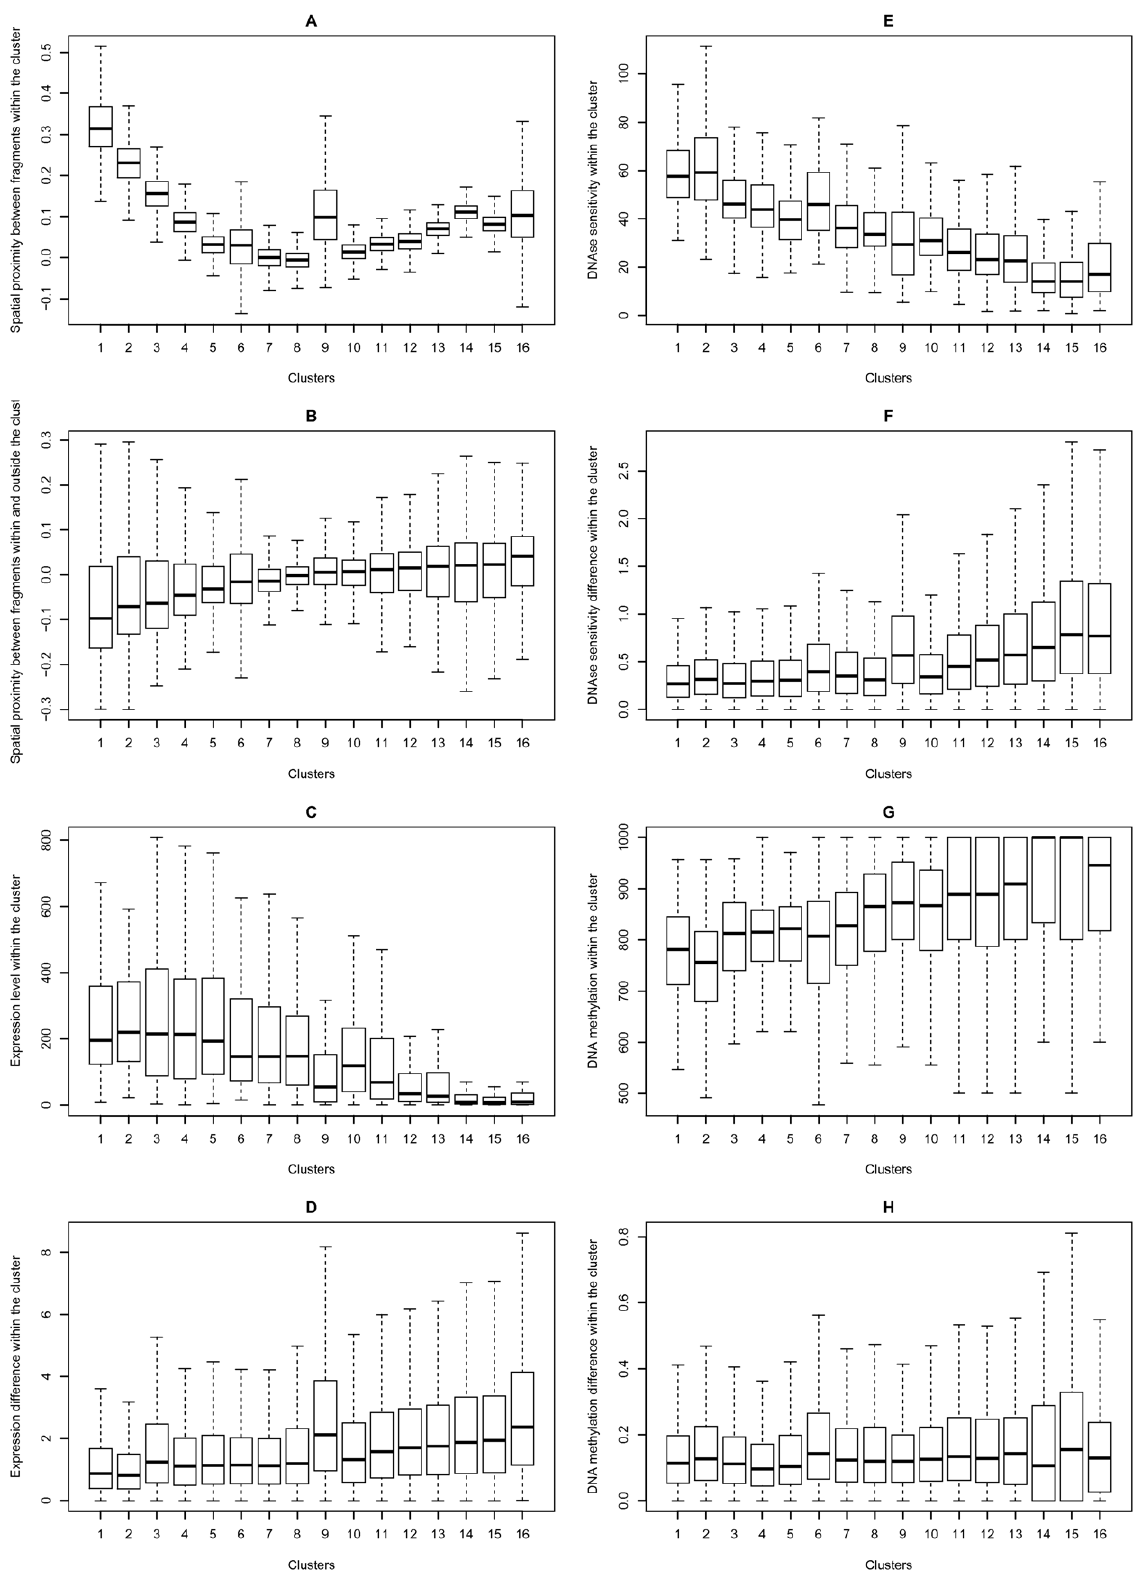
Figure 8. DNA fragments clustered into 16 groups. (A) spatial proximity between all possible pairs of DNA fragments within the cluster; (B) spatial proximity between each DNA fragment within the cluster and each DNA fragment from the remaining set; (C,E,G) expression, DNAse sensitivity, and DNA methylation levels within the cluster; (D,F,H) expression, DNAse sensitivity, and DNA methylation differences within the cluster. See Fig. S10, S11, S12, S13 for DNA fragments clustered into 4, 8, 32, and 64 groups, respectively. doi:10.1371/journal.pone.0033947.g008 PLoS ONE |